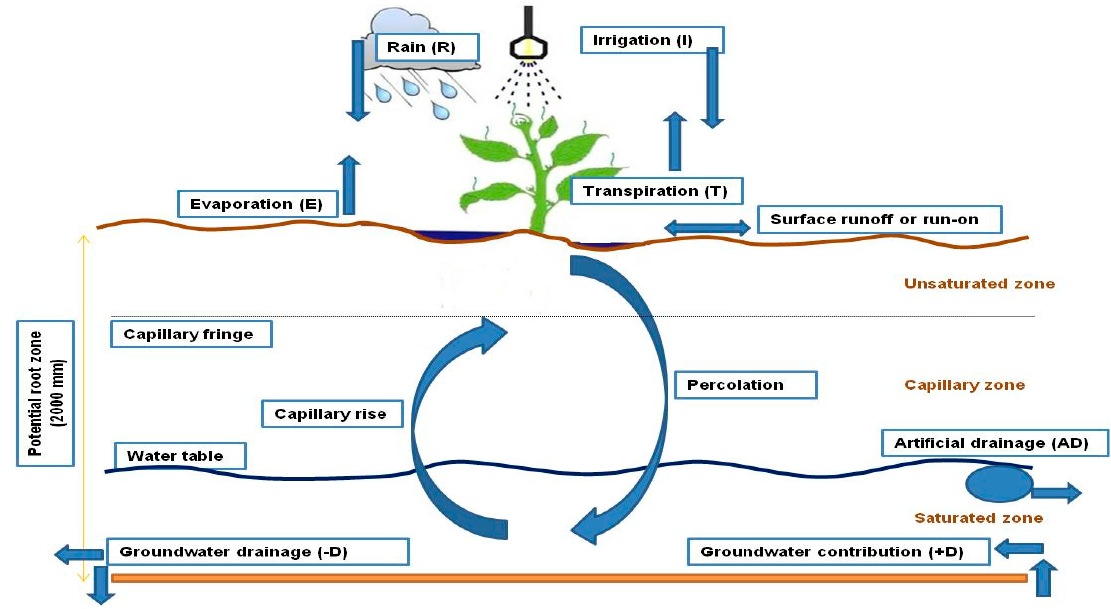
Figure 1. Procedure conceptualization of the field experiment.